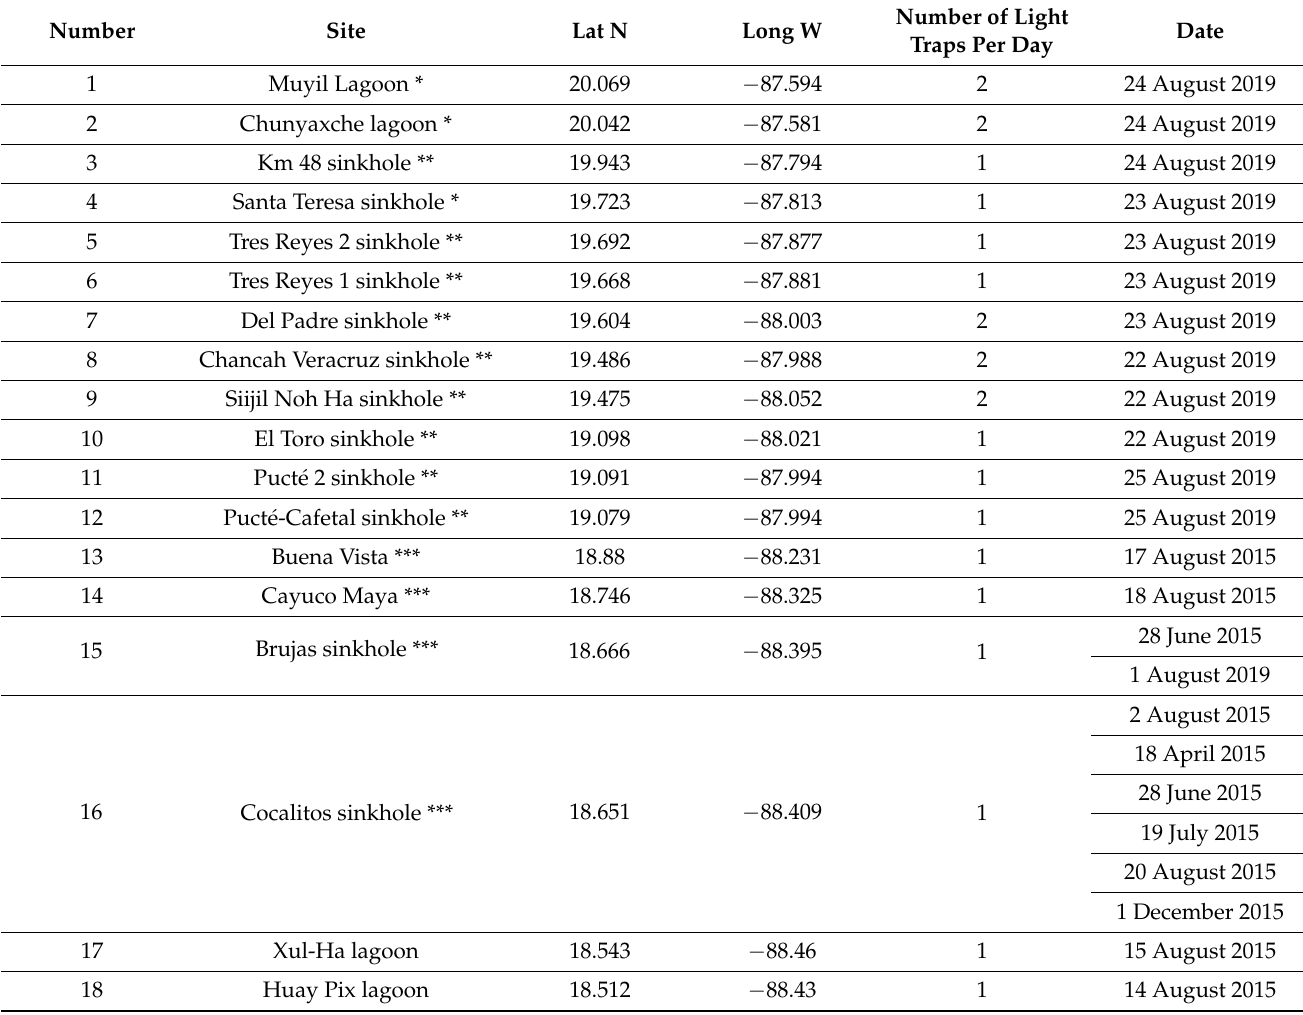
Table 1. Collection sites * inside Sian Ka’an reserve, ** nearby of the reserve, *** inside Lake